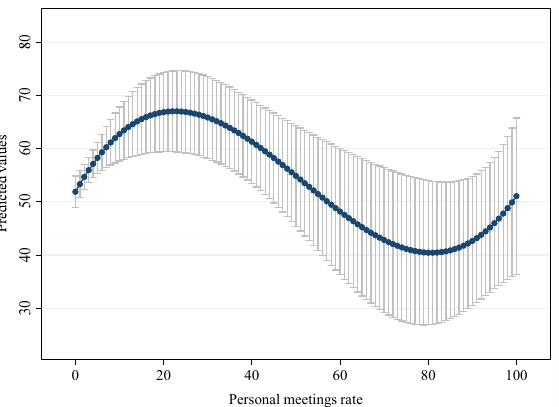
Figure 2. Predicted values for percentage of the vote according to personal meetings rate. Source: prepared by the authors with data from www.servel.cl and www.infolobby.cl (accessed on 21 March